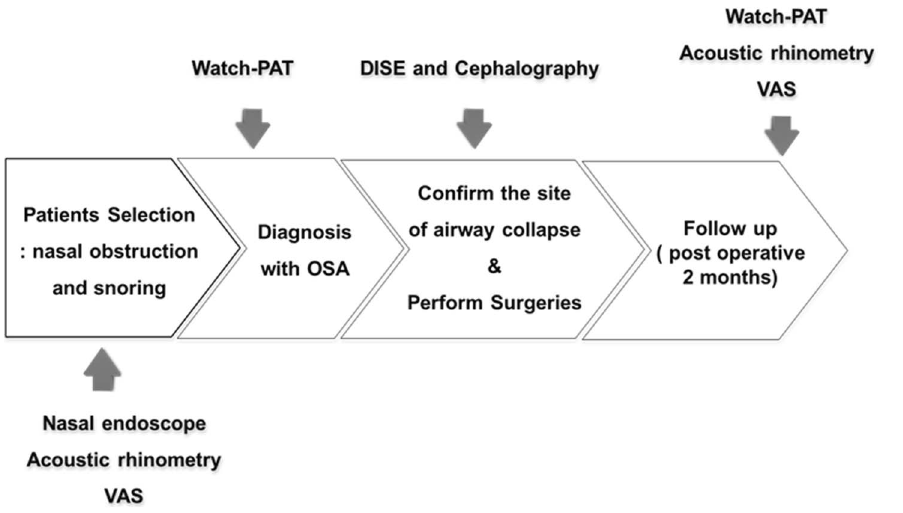
Figure 1. Diagnostic approach to OSA and post-operative evaluation of study subjects. VAS: Visual analogue scale, DISE: Drug-induced sleep endoscopy, OSA: Obstructive sleep apnea.